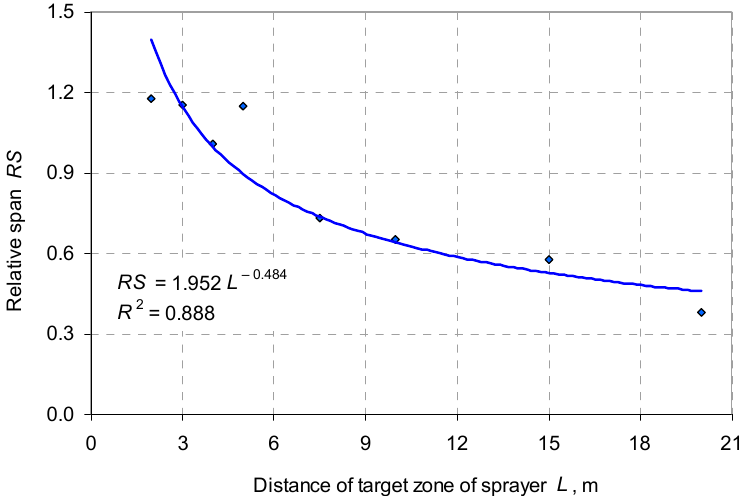
Figure 10. Relative span RS of droplets as a function from distance of target zone of sprayer L when spraying DRA7e with a sprayer with five air-injector flat spray nozzles (lateral wind velocity v = 10 m s − 1 )